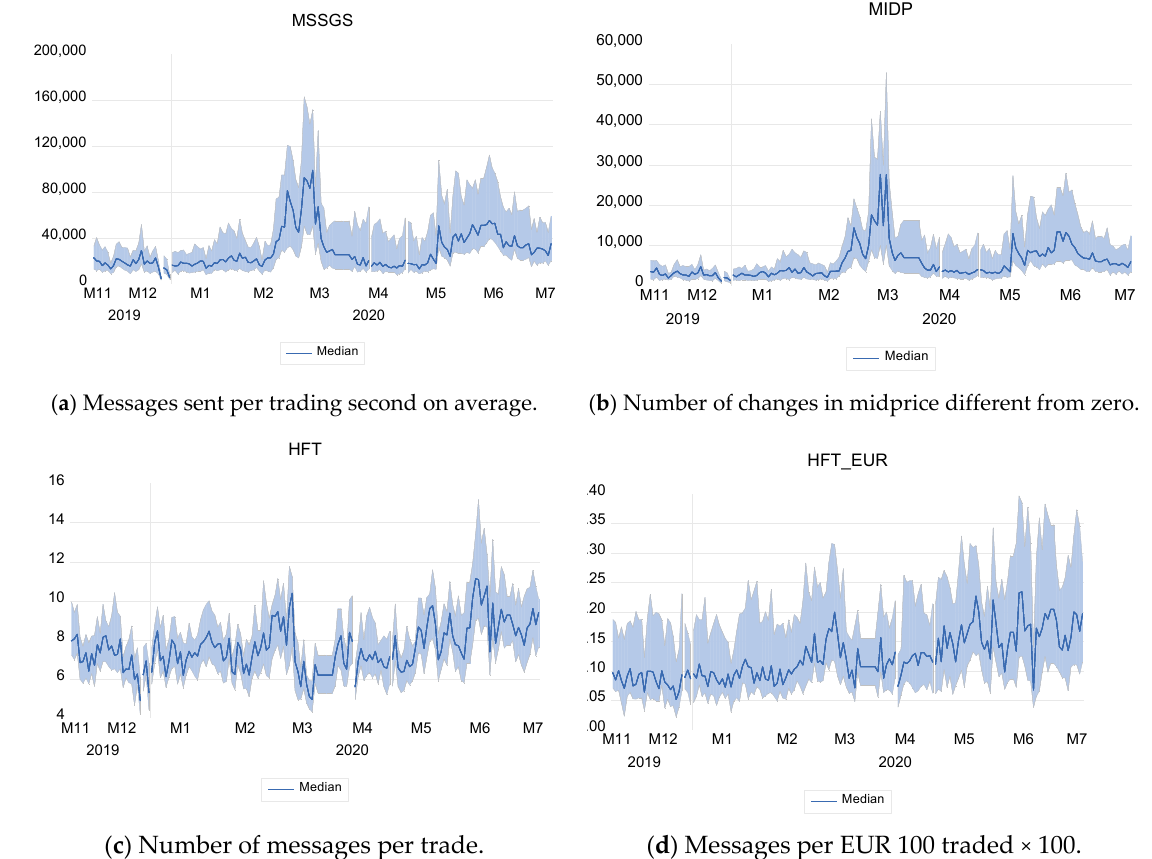
Figure 1. This figure shows the evolution of the values of the different proxies of high-frequency activity used in this paper between 20 November 2019 and 13 July 2020. More precisely, ( a ) shows the number of messages sent per trading second on average; ( b ) presents the number of changes in midprice different from zero; the number of messages per trade can be seen in ( c ); ( d ) corresponds to the number of messages per EUR 100 traded scaled by